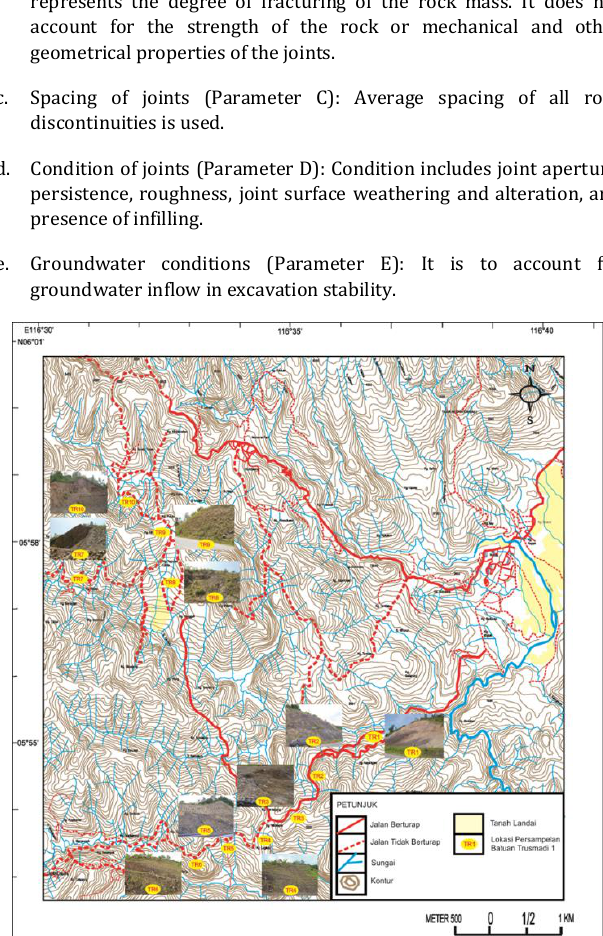
Figure 2: Selected rock slopes location with their photographs Table 1 is the RMR system classification updated in 1989. Part A of